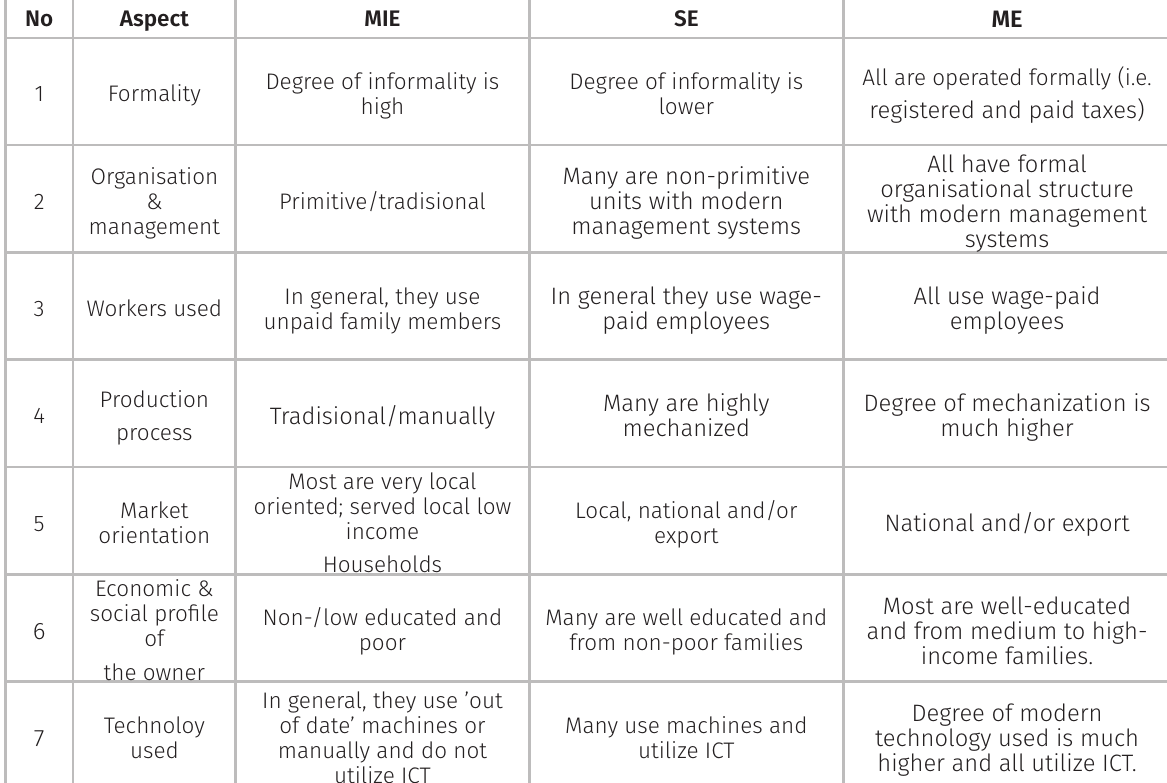
Key characteritics of MSMEs